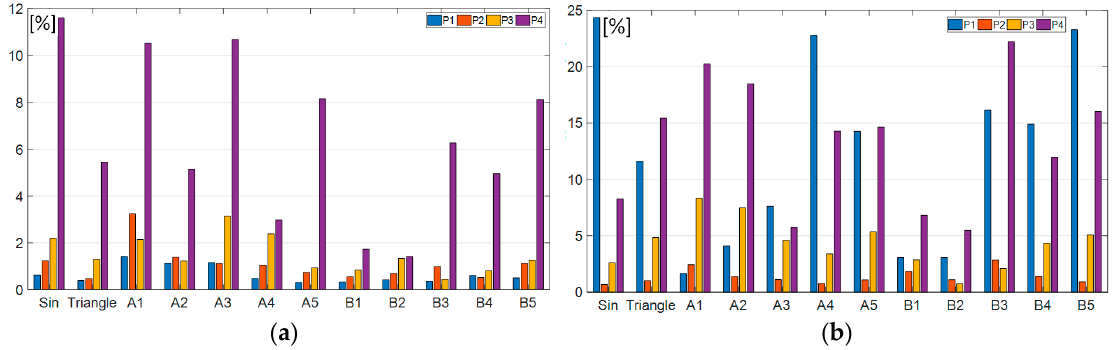
Figure 9. Coefficient of variation for energy (CVE) for: ( a ) CI-1 ( b ) CI-2. Figure 9. Coe ffi cient of variation for energy (CVE) for: ( a ) CI-1 ( b )